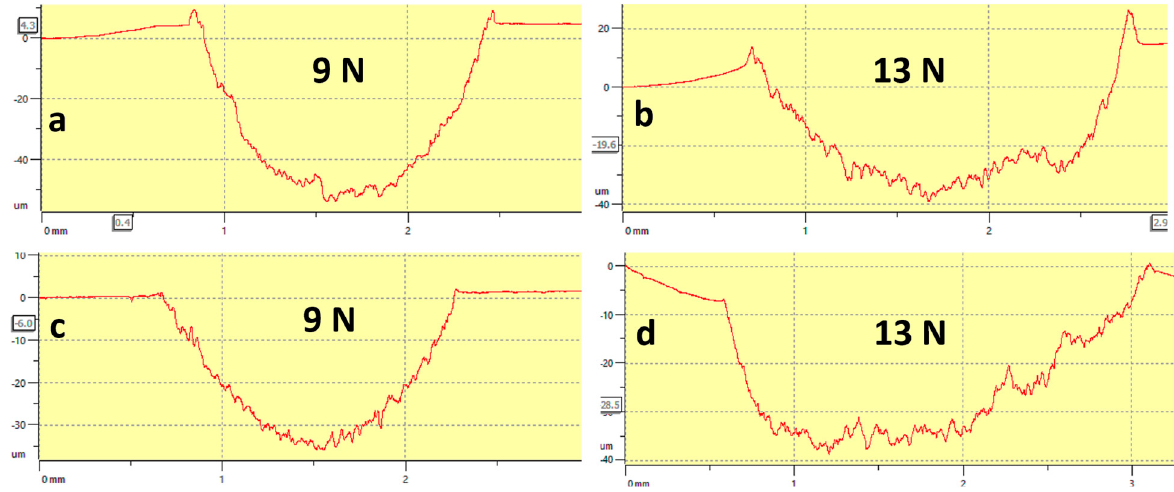
Figure 14. The profilometer’s wear depth of the sintered samples ( a , b ) T0.0 and ( c , d )